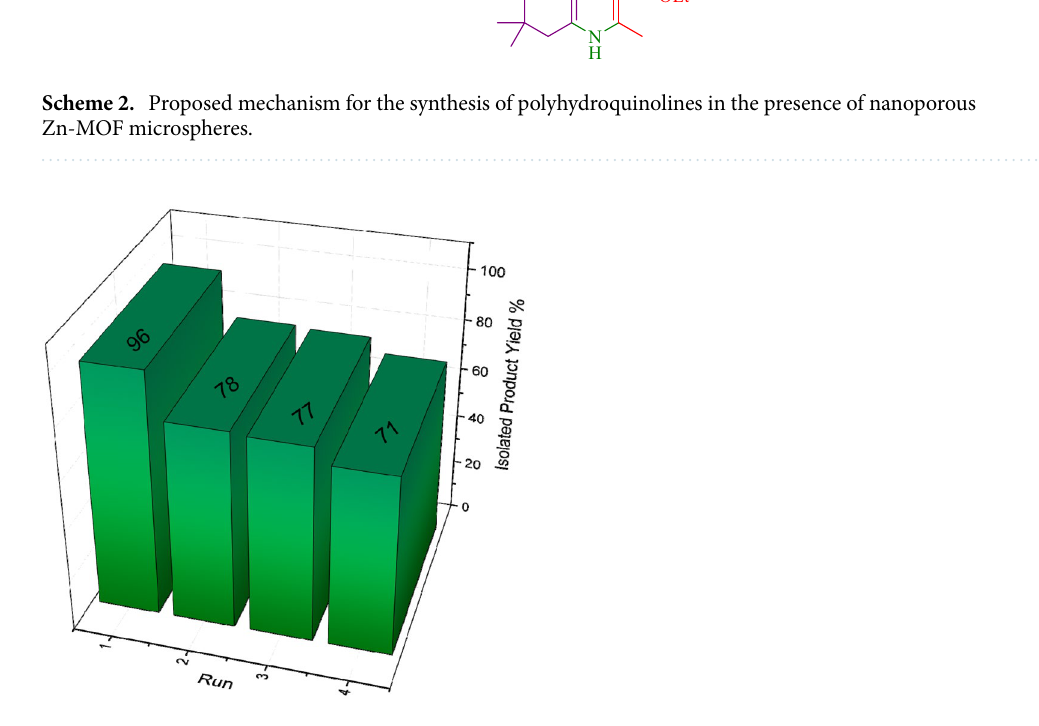
Figure 9. Recyclability of the nanoporous Zn-MOF